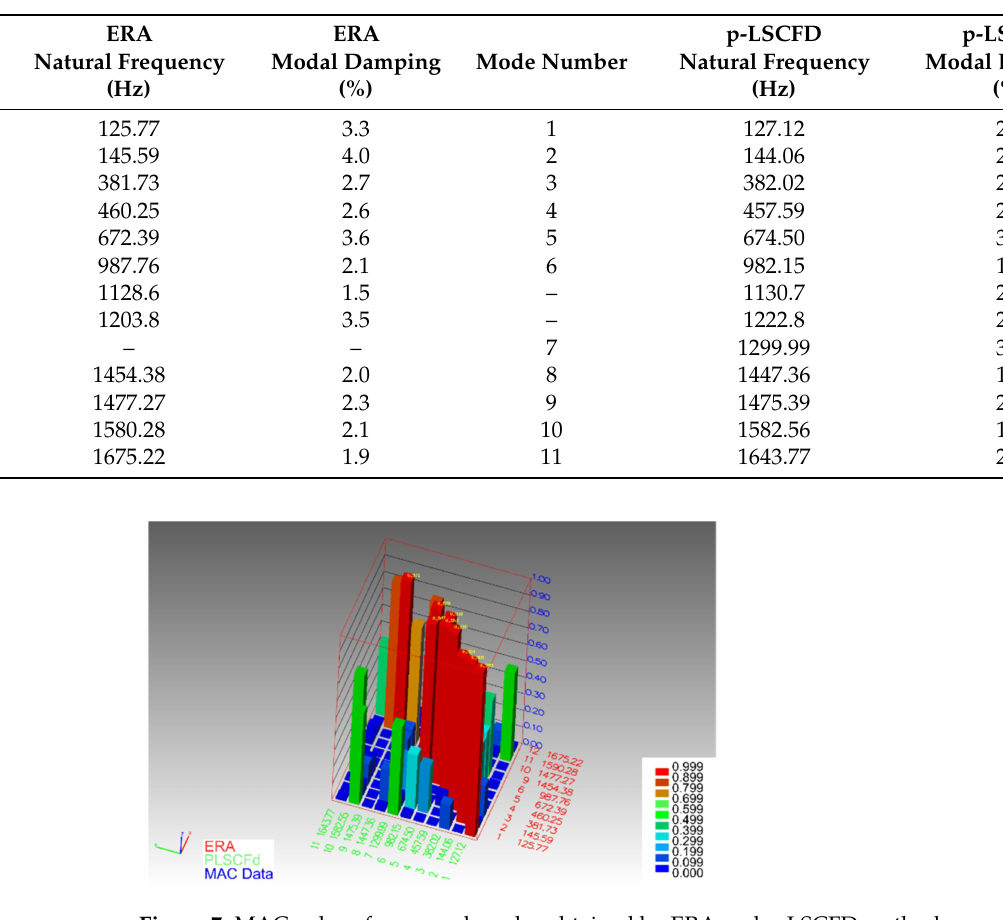
Figure 7. MAC values for normal modes obtained by ERA and p-LSCFD methods.